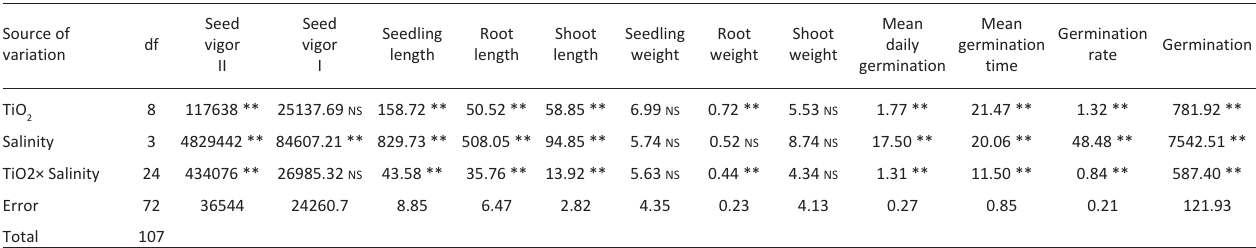
Table 1 ­ Analysis of variation of nano and bulk titanium dioxide particles on germination and seedling traits of Echinacea Source of df variation